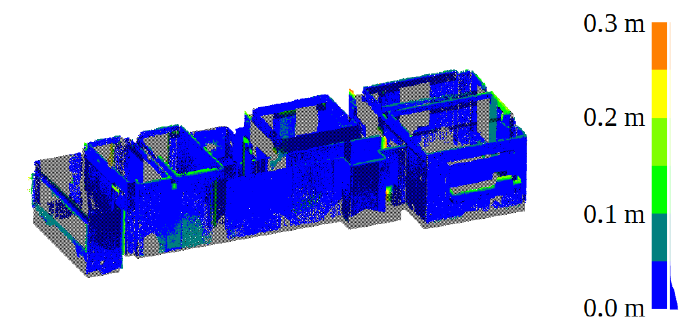
Figure 24. Point clouds colored with distance between points and the reconstructed model.